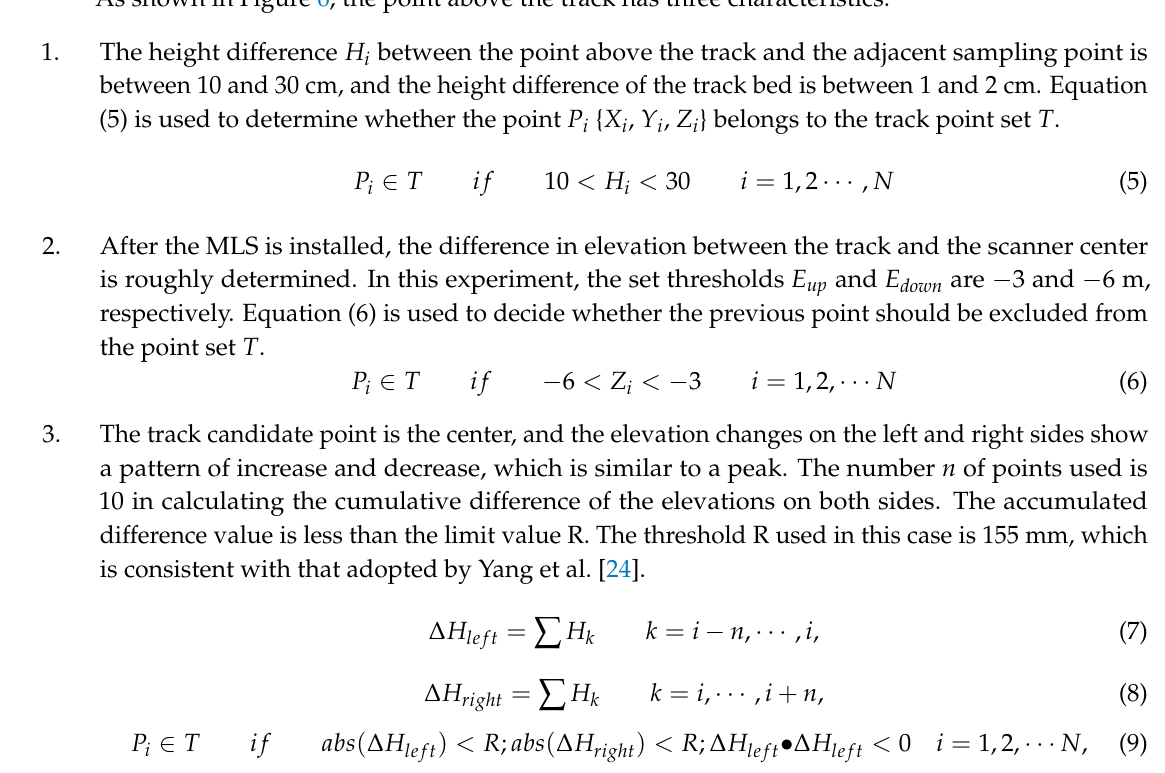
Figure 6. Elevation difference on one scan line.